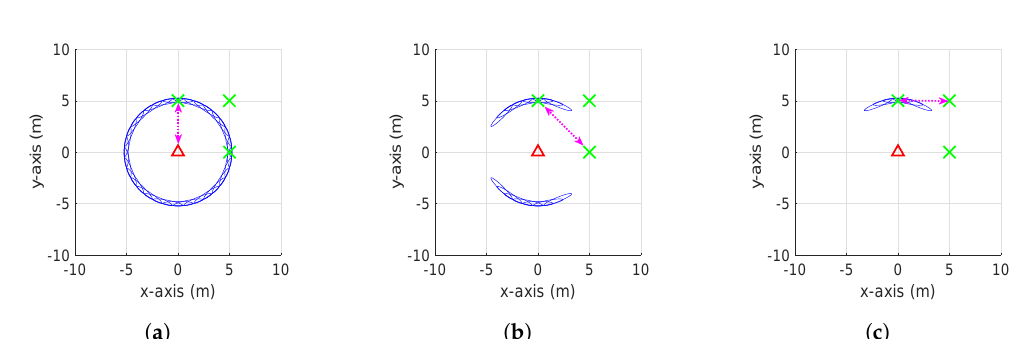
Figure 3. Explanation of the weight update scheme in the CDRO-SLAM. Red triangles and green crosses indicate robots and neighbor nodes, respectively. Black and magenta dotted lines are the movement of the robot and range measurements, respectively. Blue ellipse is a possible location of nodes. The CDRO-SLAM involves ( a ) the initialization of the SoG variables when receiving the first measurement, ( b ) determining the SoG distribution after updating the weight with the first inter-node measurement, and ( c ) the second inter-node